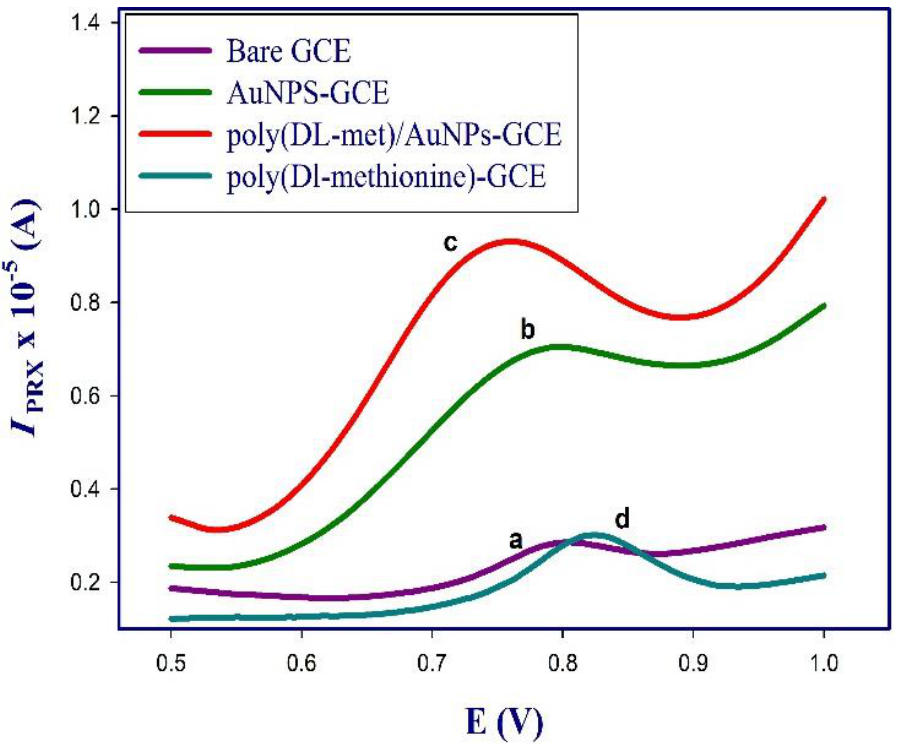
Figure 2. DPV of 10 µM PRX in PBs pH 7.5 on the surface of bare GCE (a), AuNPs-GCE (b), poly ( DL -met)/AuNPs-GCE (c) and poly ( DL -met)-GCE (d) from 0.5 to 1.0 V at step potential of 0.005 V and pulse amplitude of 0.1 V.